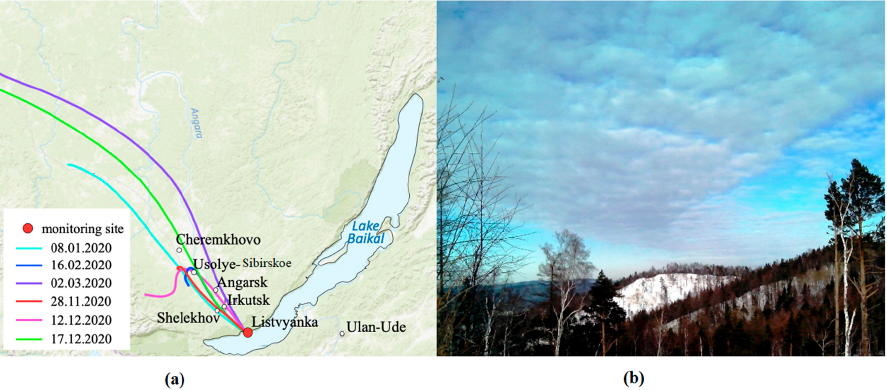
Figure 4. Back-trajectories of air transport (250 m) for days with SO 2 concentrations in Listvyanka exceeding MPCs ( a ); an example of an air plume from a remote thermal power plant above the coastal hills near Listvyanka ( b ) (photo by Obolkin).